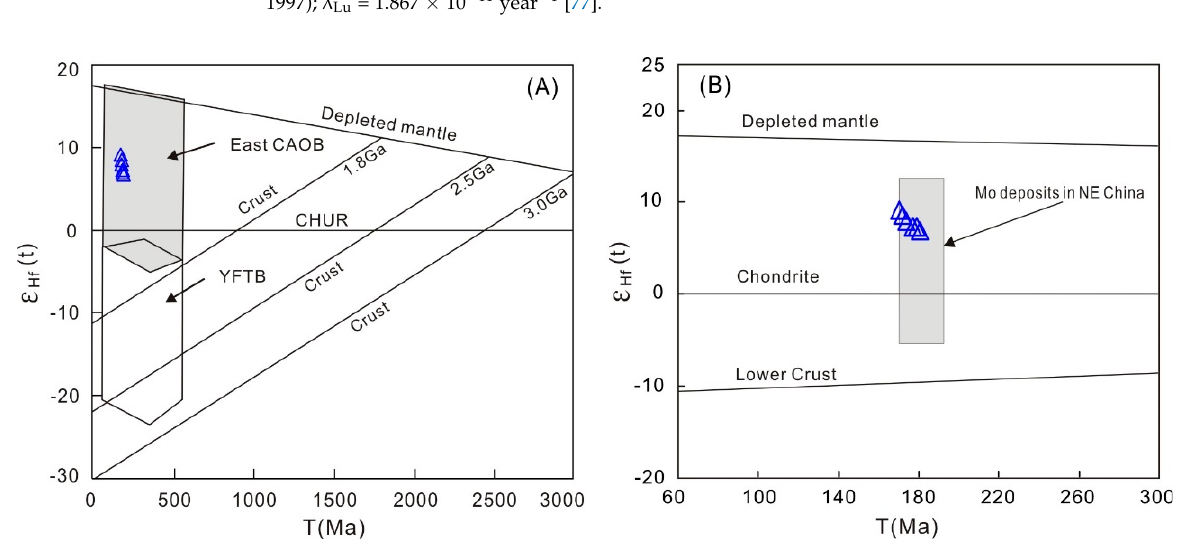
Figure 6. Zircon Hf isotopic characteristics of monzogranite. CHUR: bulk earth chondritic uniform reservoir. ( A ) The characteristic of Hf isotopic composition, ( B ) ε Hf (t) versus T (Ma) diagram of Mo deposits in NE China. Table 4. Zircon Hf isotopic compositions for monzogranite in the Chang'anpu Mo deposit.